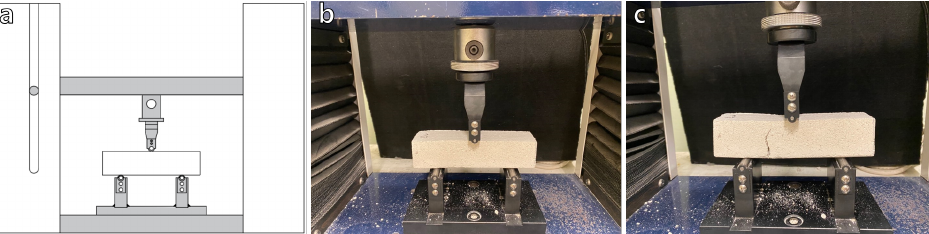
Figure 12. Mortar flexural test. ( a ) Setup for the mortar flexure test ( b ) before testing, ( c ) after testing.